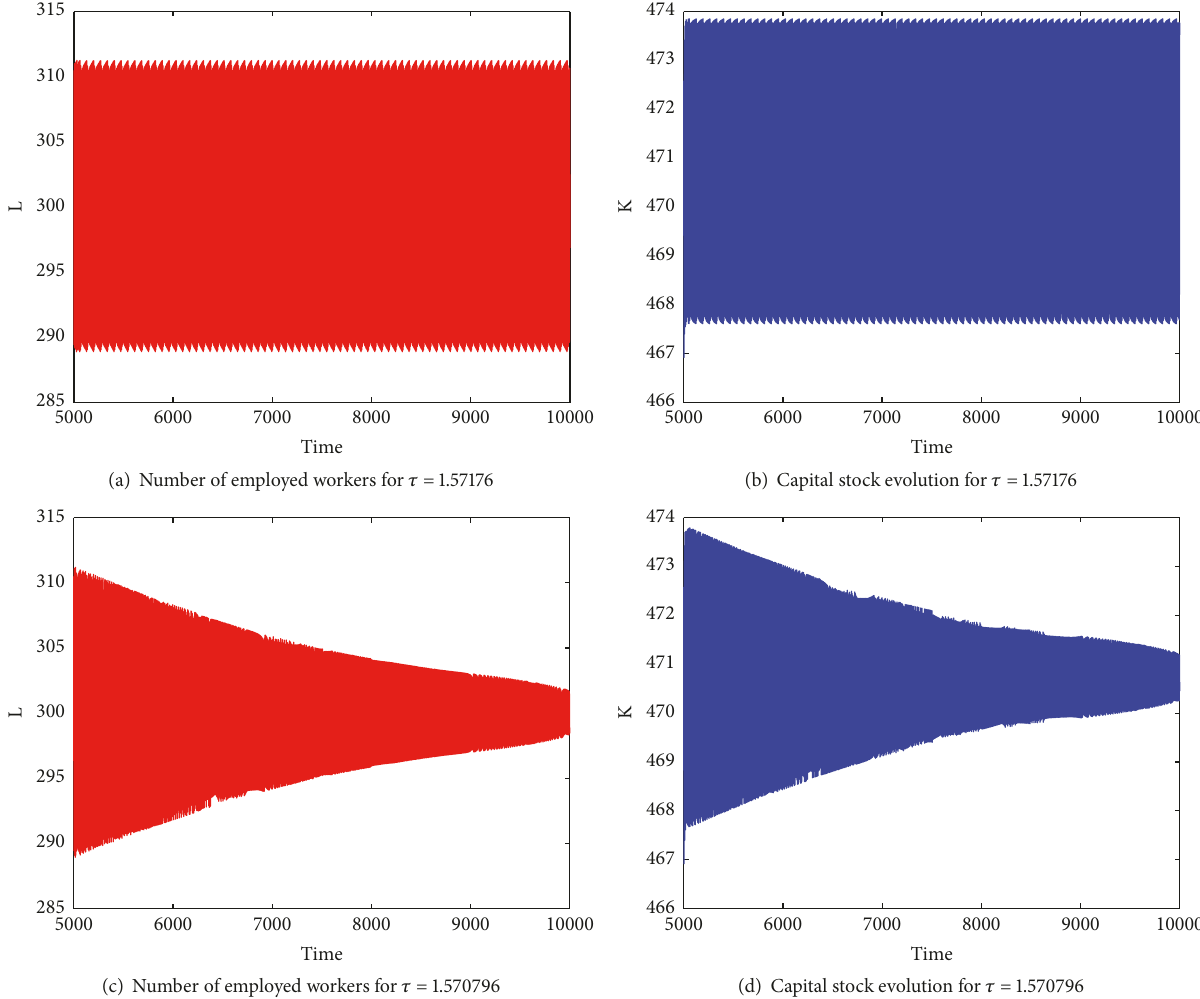
Figure 2: For 𝛼 = 0.5 , an unstable periodic solution bifurcates from the positive equilibrium: (a and b) for 1.57176 > 𝜏 0 , existence of bifurcating periodic solution and (c and d), for 1.570796 < 𝜏 0 , absence of bifurcating periodic solution (see Theorem